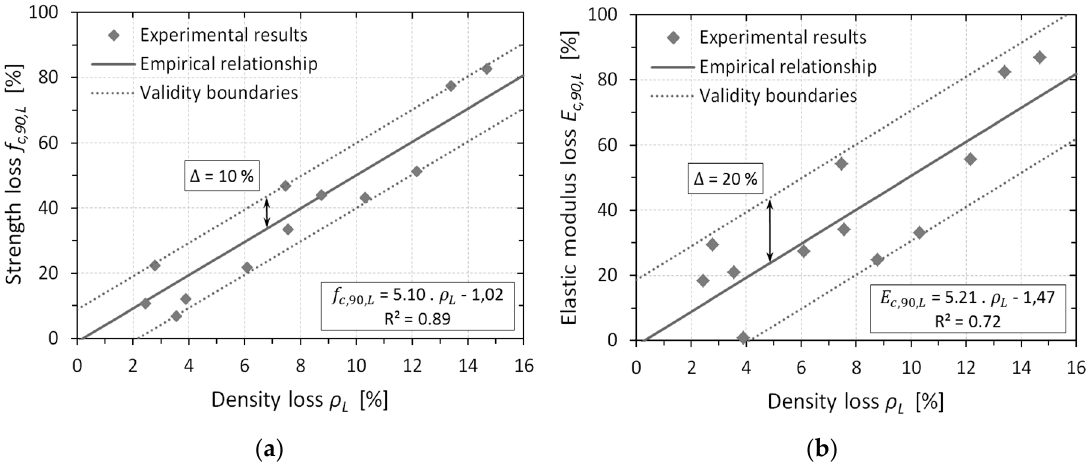
Figure 10. Experimental versus empirical values for the compressive strength loss f c ,90, L ( a ) and elastic modulus loss E c ,90, L ( b ) perpendicularly to the grain, in respect with the density loss ρ L for insect-deteriorated samples tested.